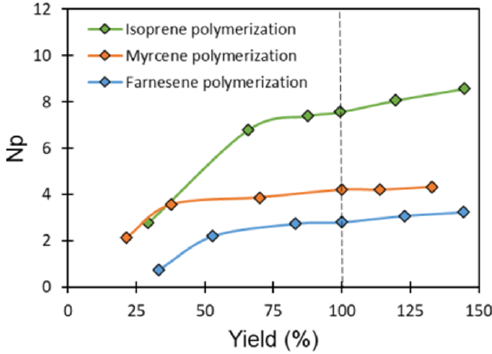
Figure 7. Dependence of N P against yield for isoprene, myrcene and farnesene polymerizations initiated by NdV 3 /Al( i -Bu) 2 H/Me 2 SiCl 2 in cyclohexane at 70 °C.